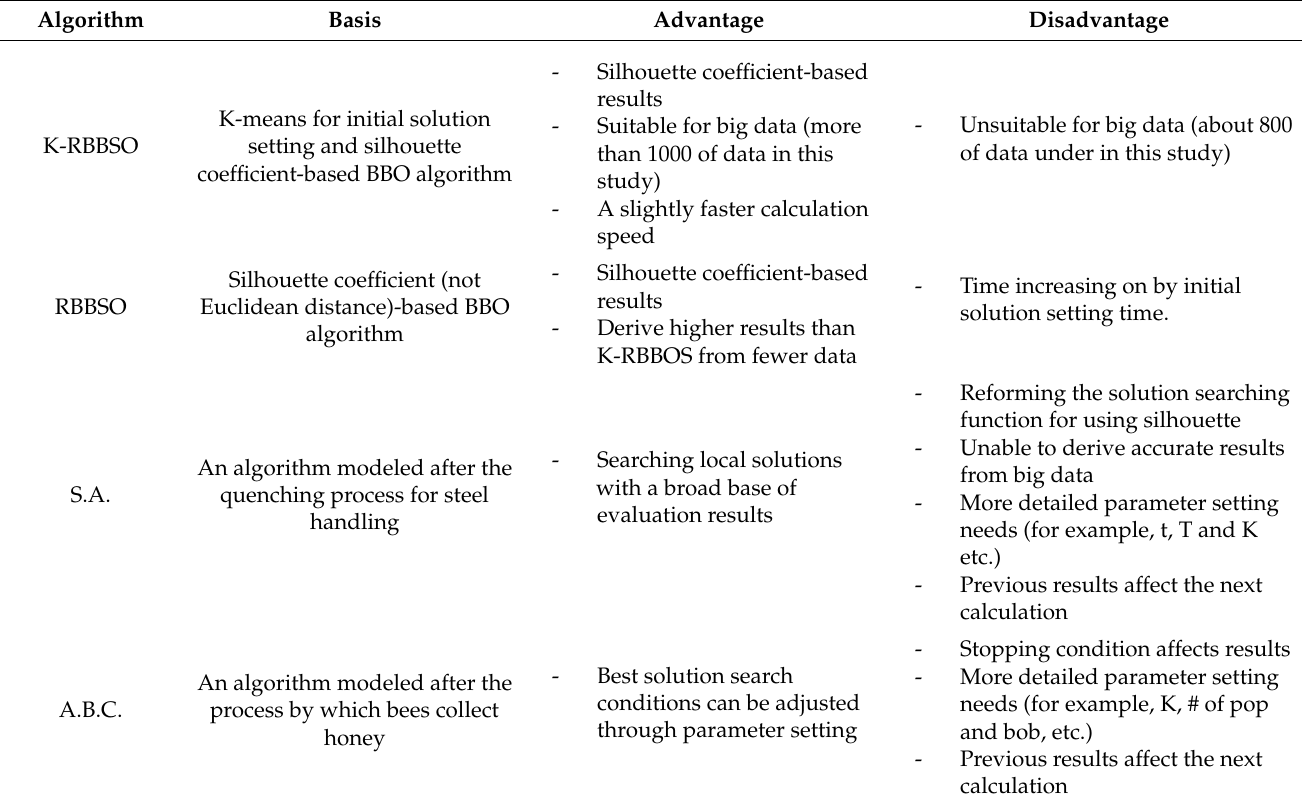
Table 4. Advantages and disadvantages of each